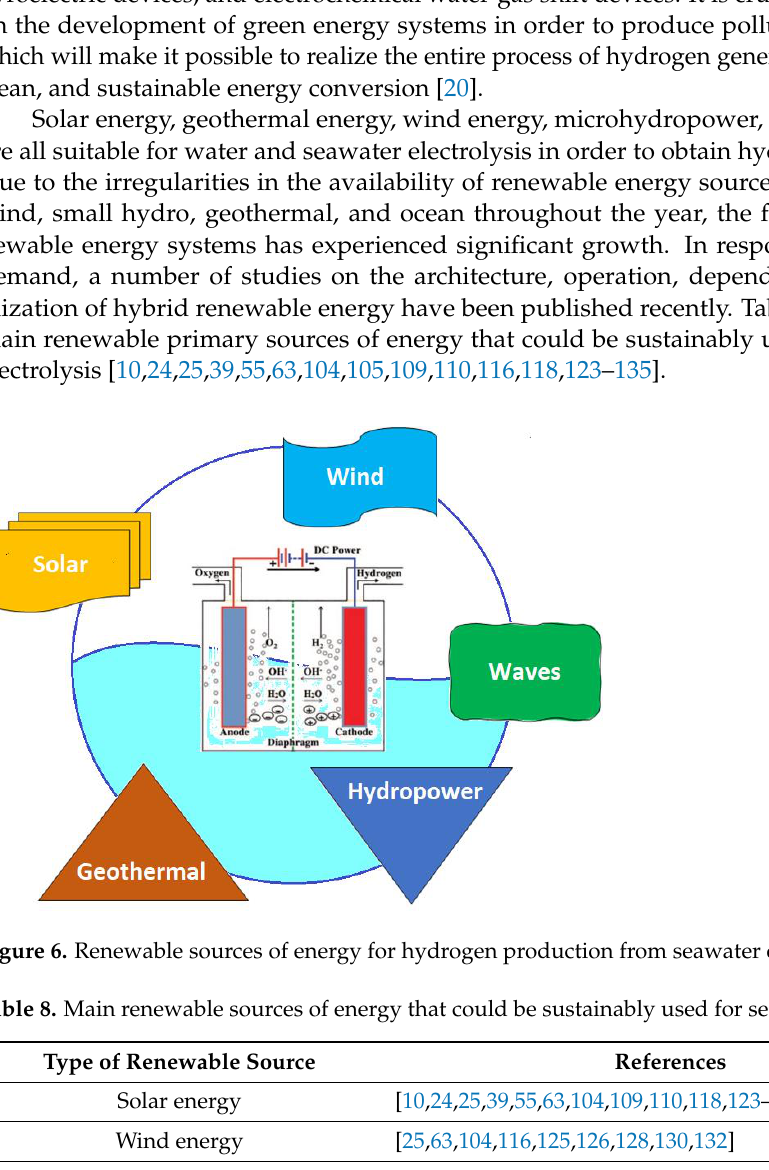
Table 8. Main renewable sources of energy that could be sustainably used for seawater electrolysis.